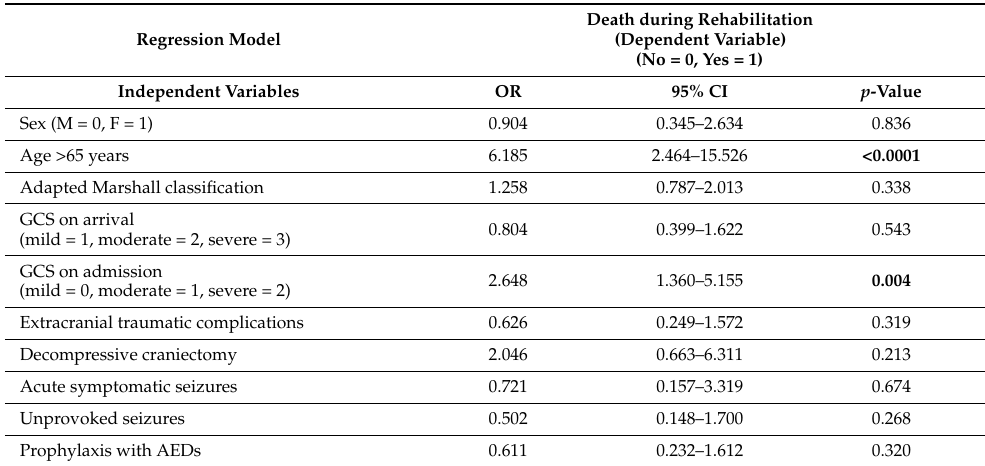
Table 3. Multivariate logistic regression analysis showing the potential risk factors for mortality within 6 months of brain